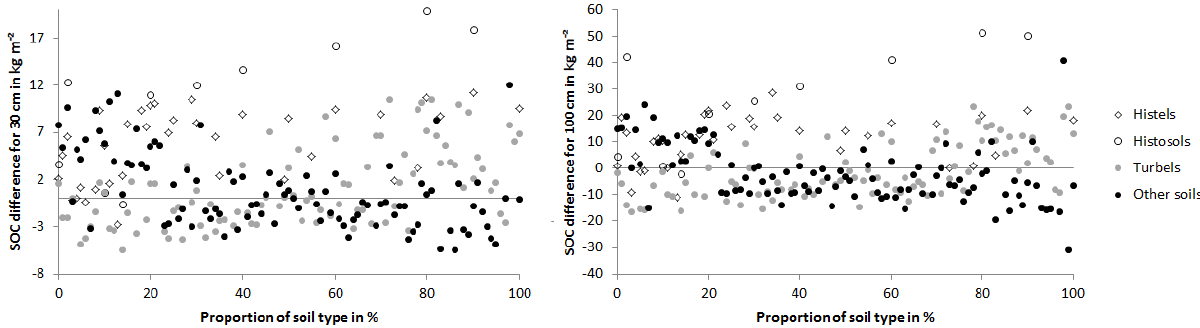
Figure 14. Averaged differences of SOC in kgm − 2 between NCSCD and GM by soil type (averaging intervals 1%; source: